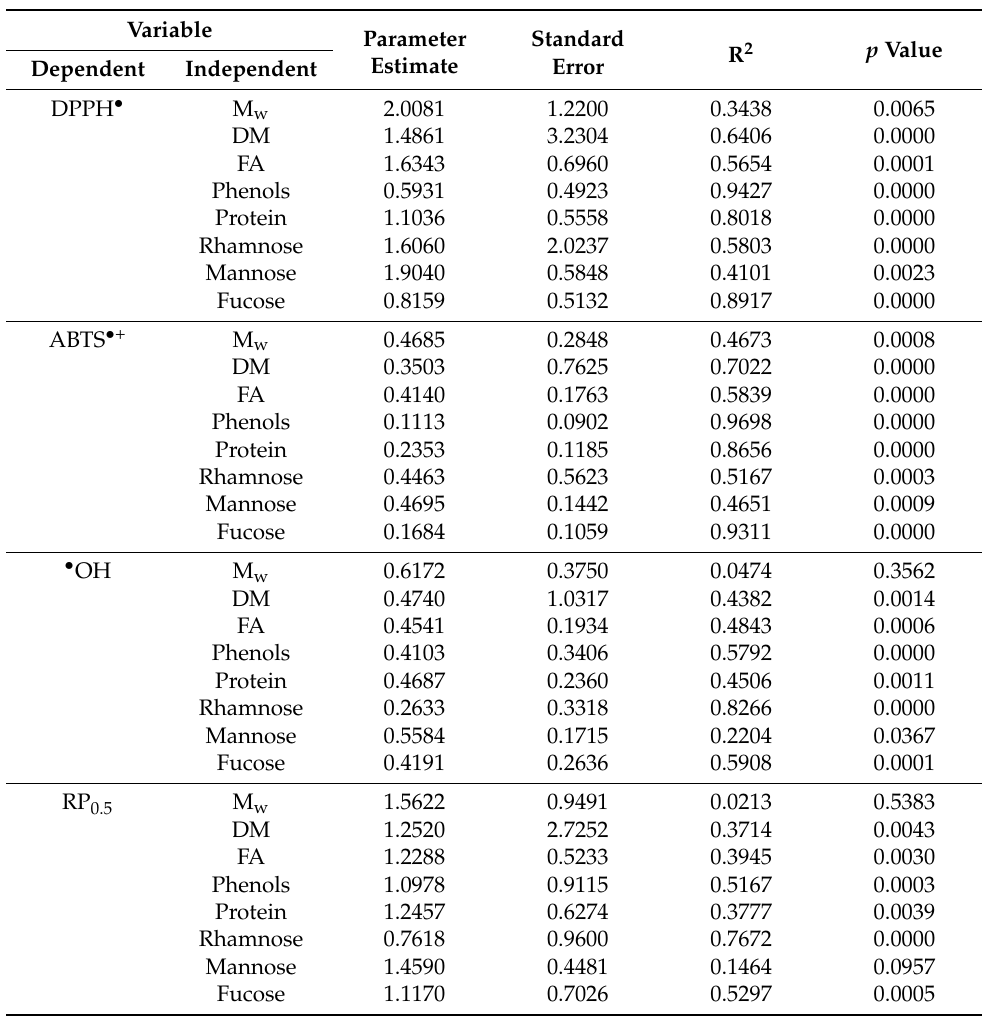
Table 3. Multiple regression analysis for IC 50 and RP 0.5 antioxidant capacity with degree of methy- lation (DM) and molecular weight (M w ) of pectins, and the contents of: ferulic acid (FA), phenols, protein, rhamnose, fucose and